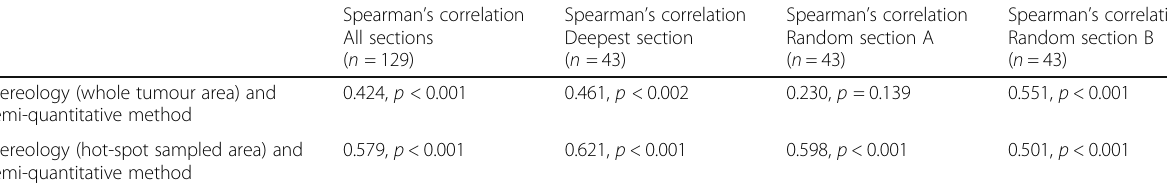
Table 1 Correlation between estimates of tumuor stroma ratio obtained semi-quantitatively and by stereology Spearman ’ s correlation All sections